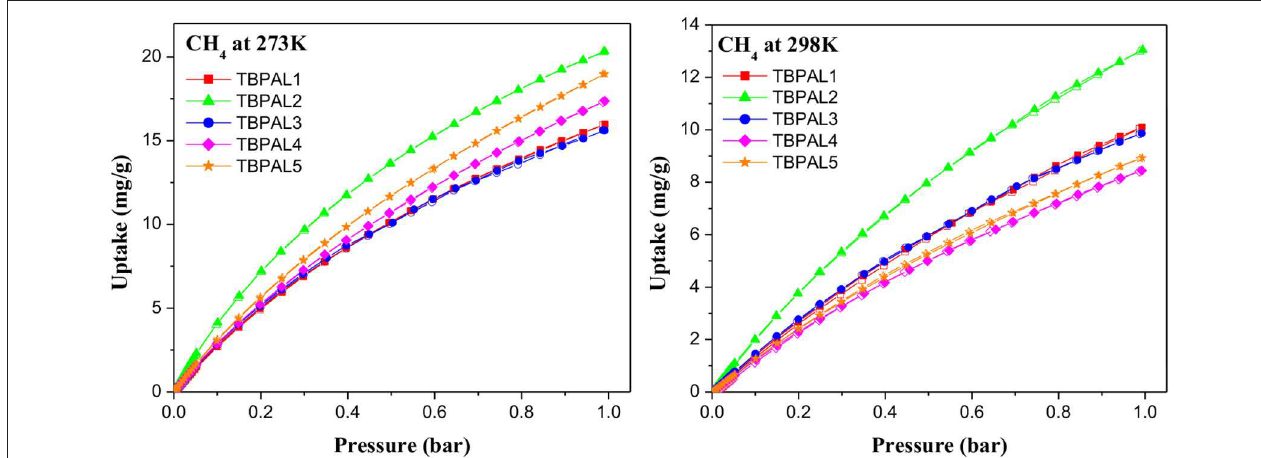
FIGURE 9 | CH 4 uptake isotherm of TBPAL1–5 at 273 and 298K.